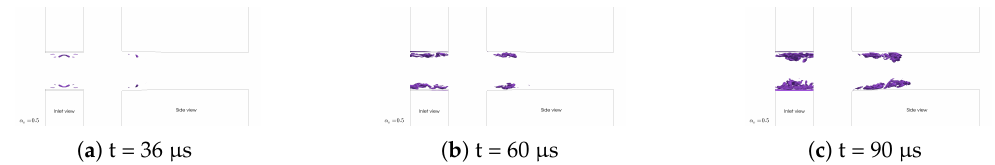
( 30,90 ] µ s) of the vapor fraction at the early instants of the Figure 23. Temporal evolution ( t ∈ simulation (incipient cavitation, ∆ p = 60bar). Iso-contour lines are plotted for α v =